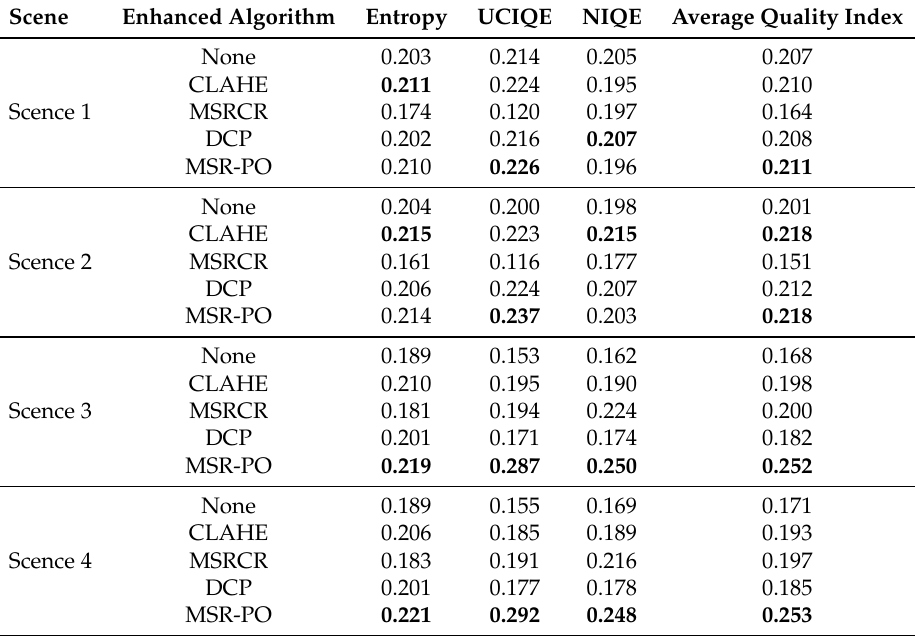
Table 2. Normalized indicator